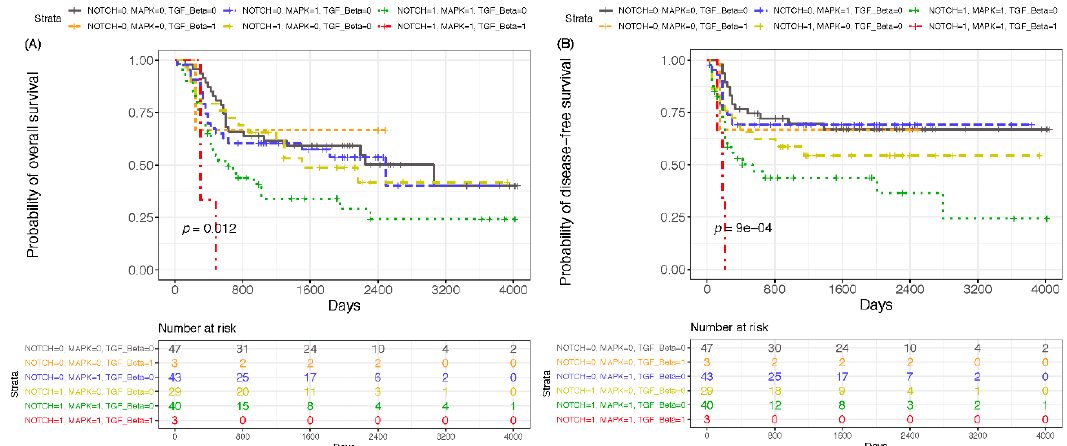
Figure 4. Overall survival (OS) and disease-free survival (DFS) according to gene alterations in three pathways. Kaplan– Meier survival curves for ( A ) OS and ( B ) DFS based on patients with mutations in NOTCH, RTK/RAS/MAPK, and TGF-beta signaling pathways. Plots were generated using the “survival” package version 3.2-3 of R software (r-project.org version 4.0.1).